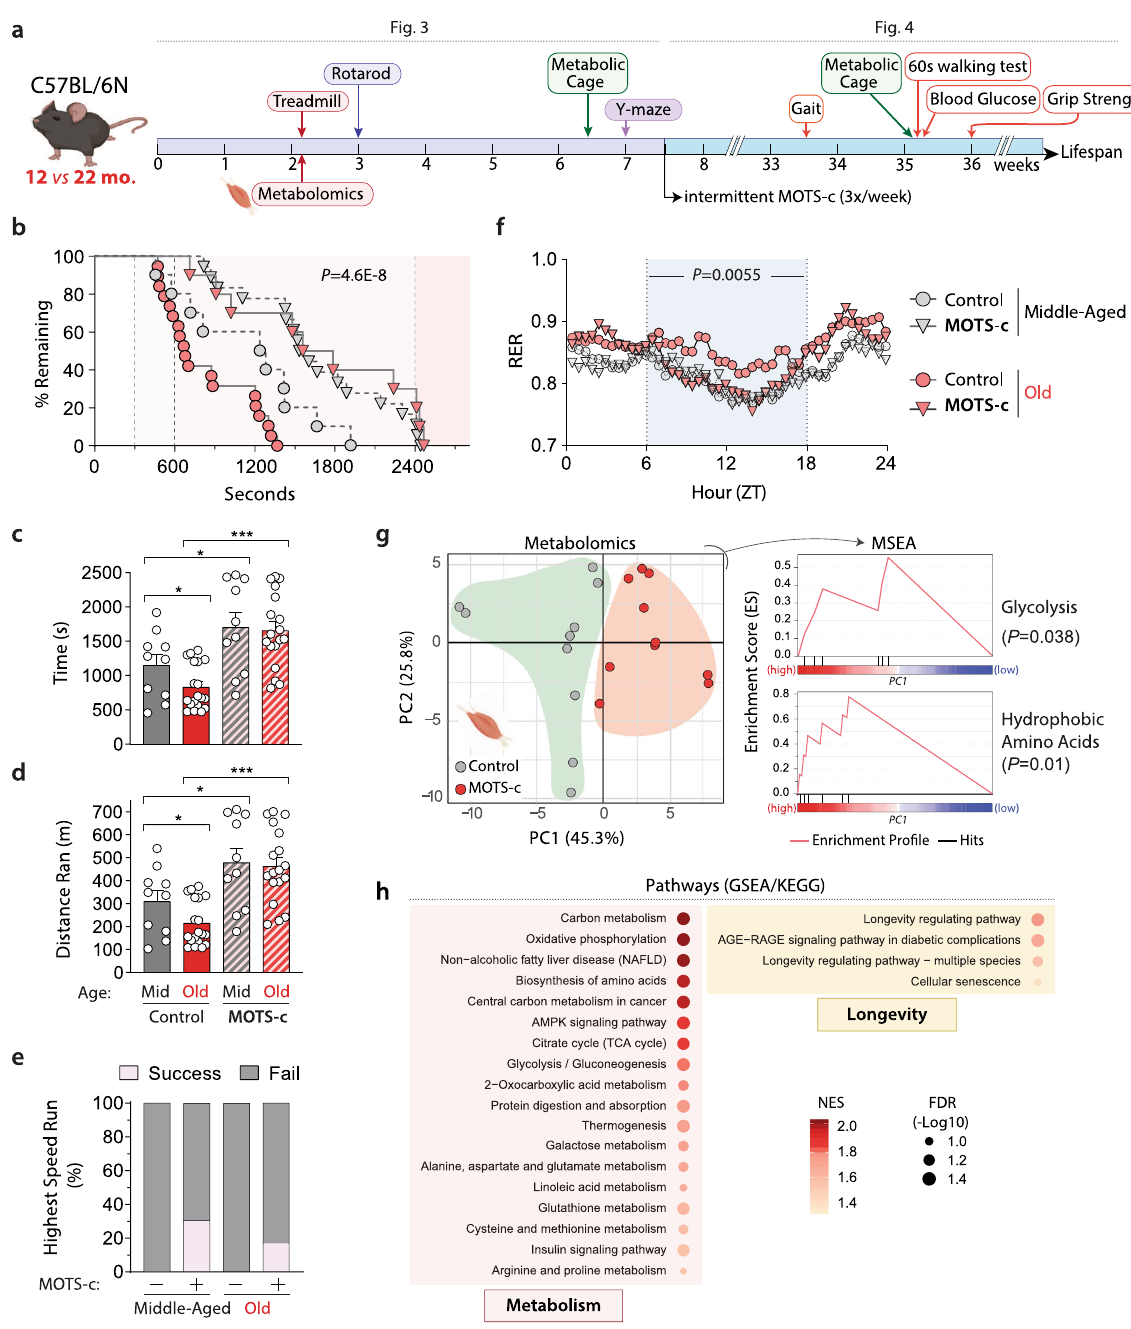
Fig. 3 Acute MOTS-c treatment enhances physical capacity in old mice. a Schedule of MOTS-c treatment and assays in middle-aged and old C57BL/ 6N mice ( n = 10, MA groups; n = 19, old control; n = 18, old MOTS-c), including b treadmill running curves ( P = 0.000000046), c total time on treadmill ( P = 0.0458, MA control vs. old control; P = 0.0497, MA control vs. MA MOTS-c; P = 0.000002, old control vs. old MOTS-c), d total distance ran on treadmill ( n = 19, old control; n = 18, Old MOTS-c; P = 0.0464, MA control vs. old control; P = 0.0462, MA control vs. MA MOTS-c; P = 0.000002, old control vs. old MOTS-c), and e percent capable of reaching the highest speed on a treadmill ( fi nal stage). f Respiratory exchange ratio (RER) following 2 weeks of daily MOTS-c injection ( n = 4; P = 0.0055). g , h Skeletal muscle from treadmill-exercised old mice (22.5 months) treated daily with MOTS-c (15 mg/kg/day) for 2 weeks ( n = 10) were subject to g metabolomics and analyzed using PCA and MSEA and h GSEA analysis of muscle RNA-seq analysis. Balloon plots of select enriched terms using Gene Ontology Biological Process (GO_BP) database at false discovery rate (FDR) < 15%. NES Normalized Enrichment Score. Full GSEA results are available in Supplementary Data 5. Data expressed as mean ± SEM. Log-rank (Mantel – Cox) test was used for b and two-way ANOVA (repeated measures) was used for f . GSEA statistics from R package ‘ clusterPro fi ler ’ were used for h . Otherwise, all statistics were performed using the two-sided Student ’ s t test. * P < 0.05, ** P < 0.01, *** P < 0.001. MA